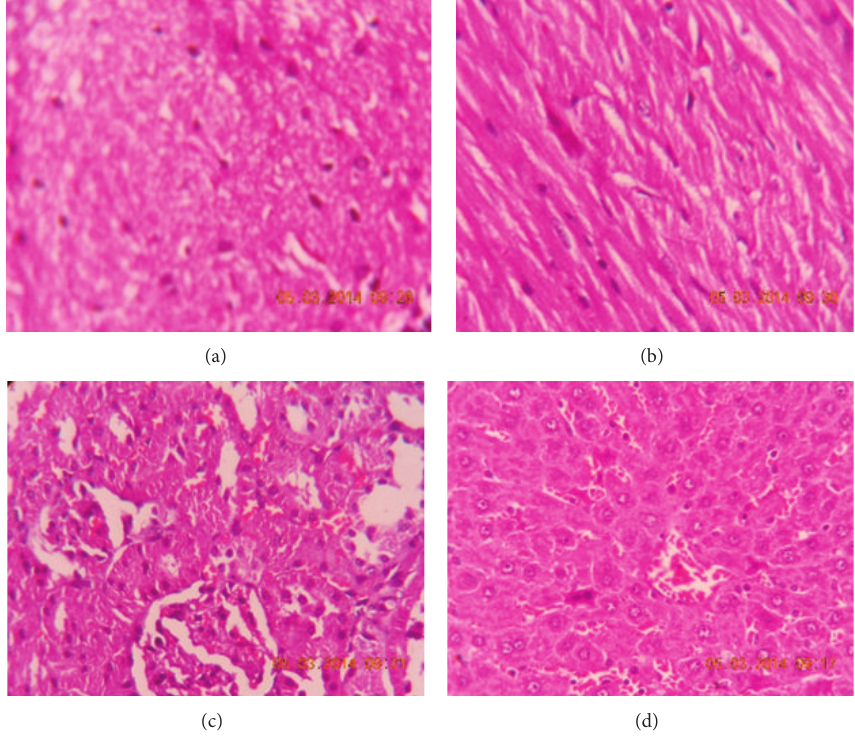
Figure 8: Photomicrograph of (a) brain, (b) heart, (c) kidney, and (d) liver of control group.